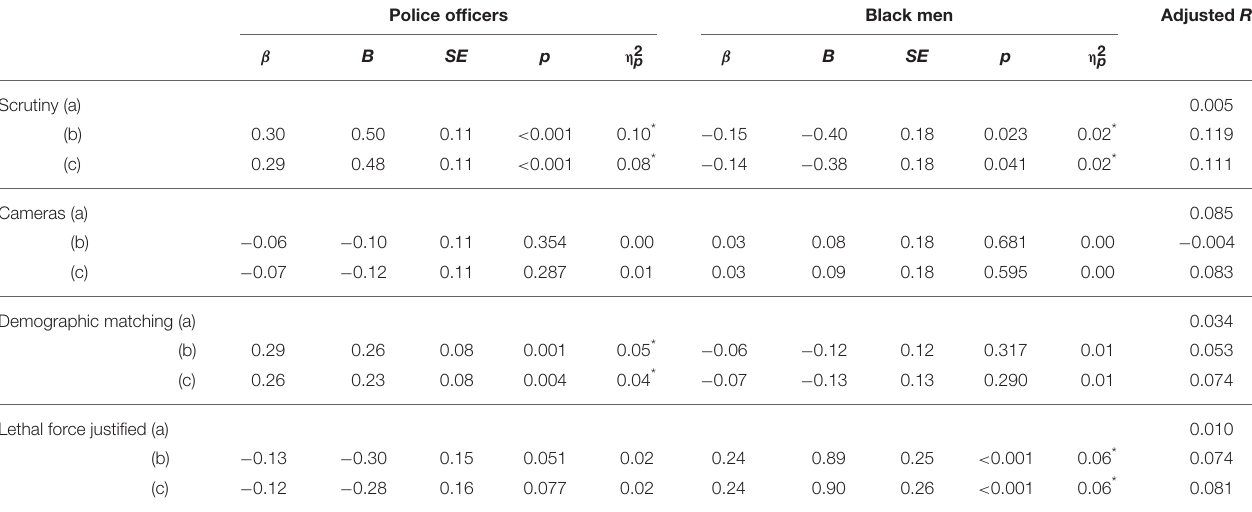
TABLE 2 | Results of Study 1a regression analysis using threat associated with police officers and Black men to predict support for policing policy reform